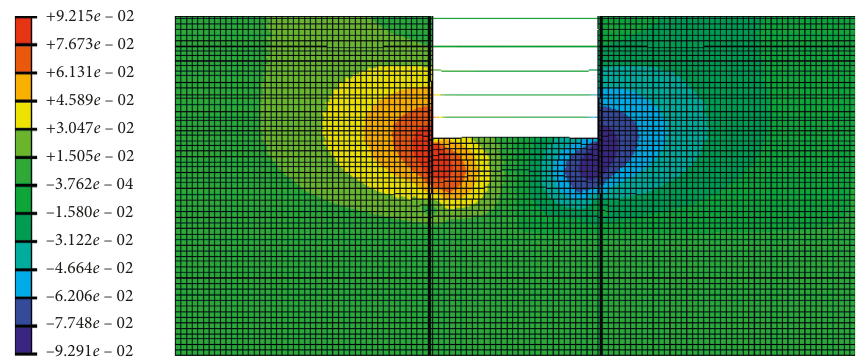
Figure 13: Soil horizontal displacement cloud diagram on the centre section.